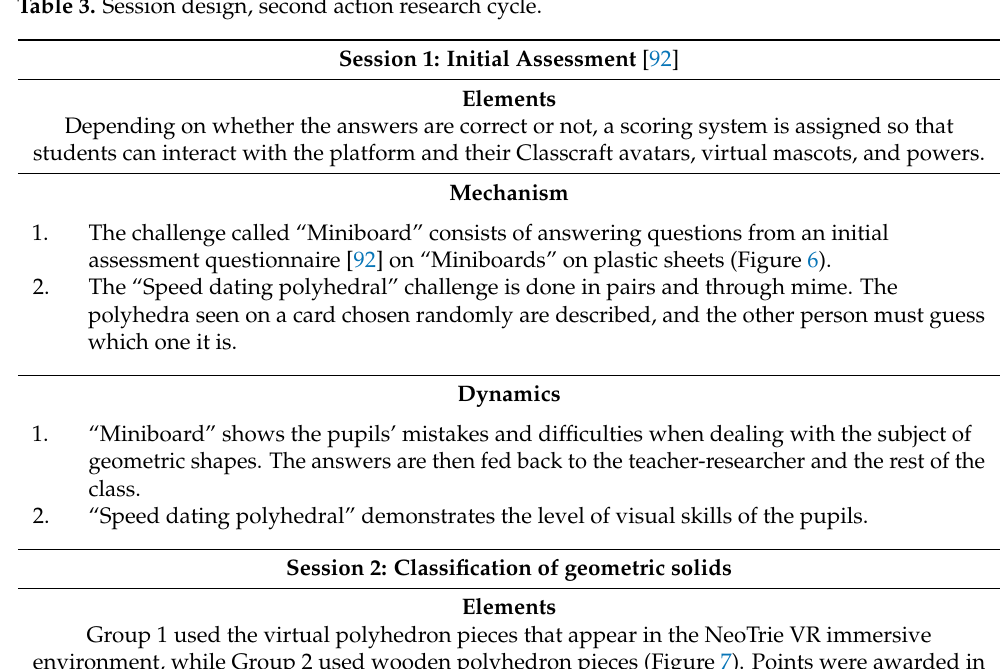
Table 3. Session design, second action research